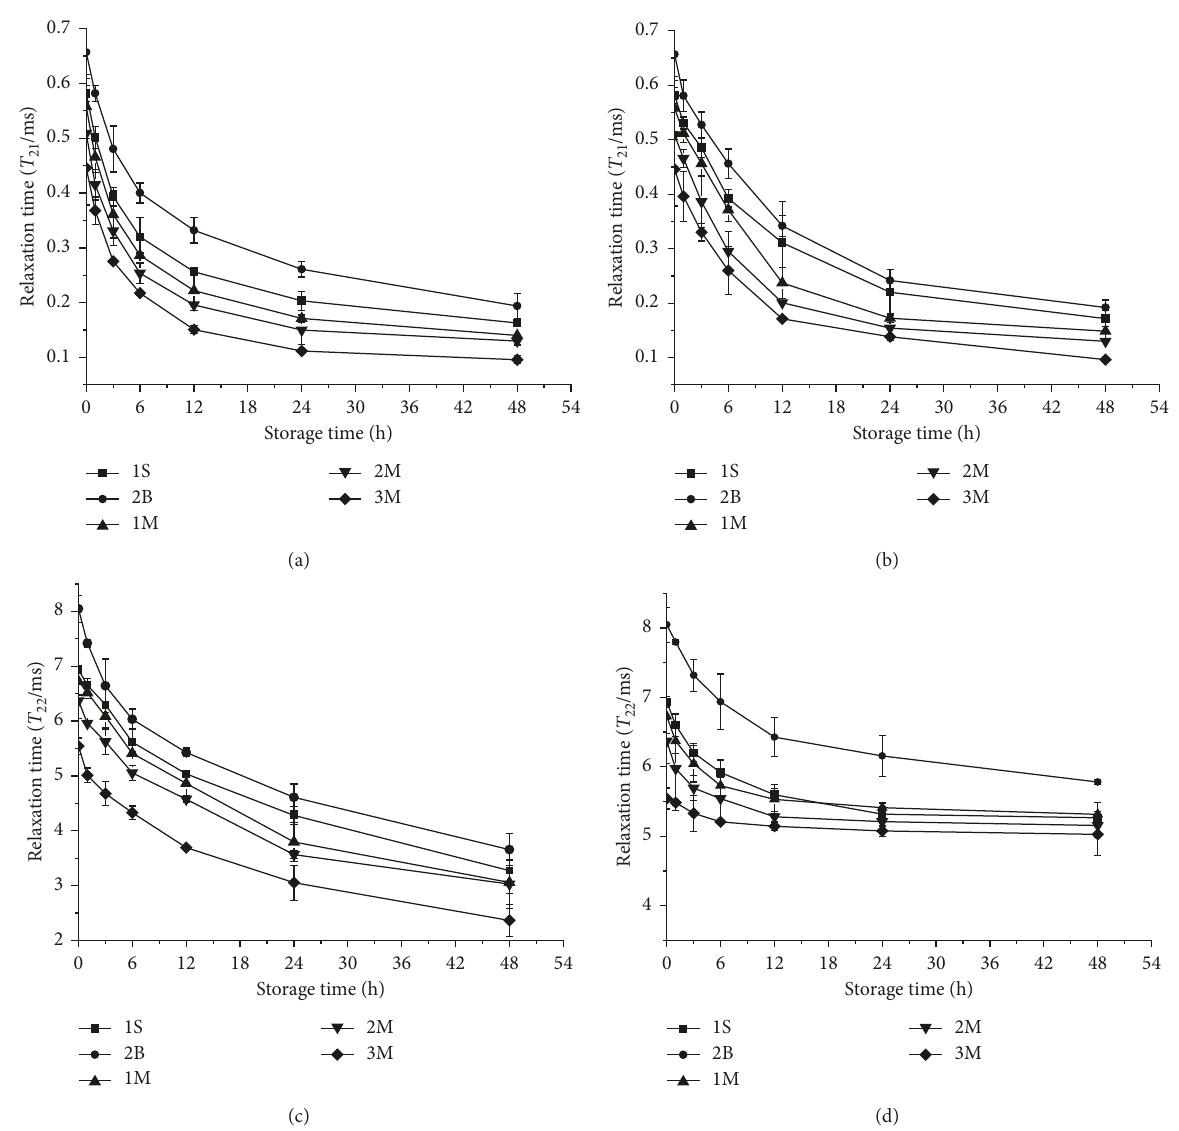
Figure 1: The water status of fresh wet noodles during storage. Relaxation time T